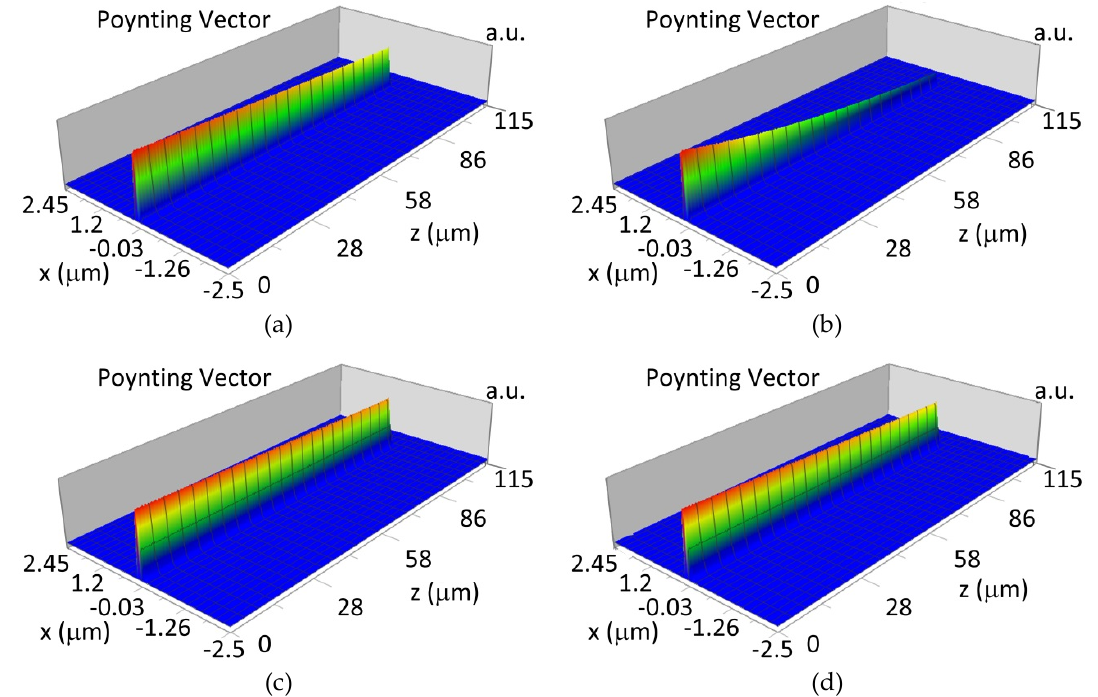
Figure 15. Propagation light in waveguide structure for TM00, d w = 188 nm (Poynting vector): ( a ) λ =